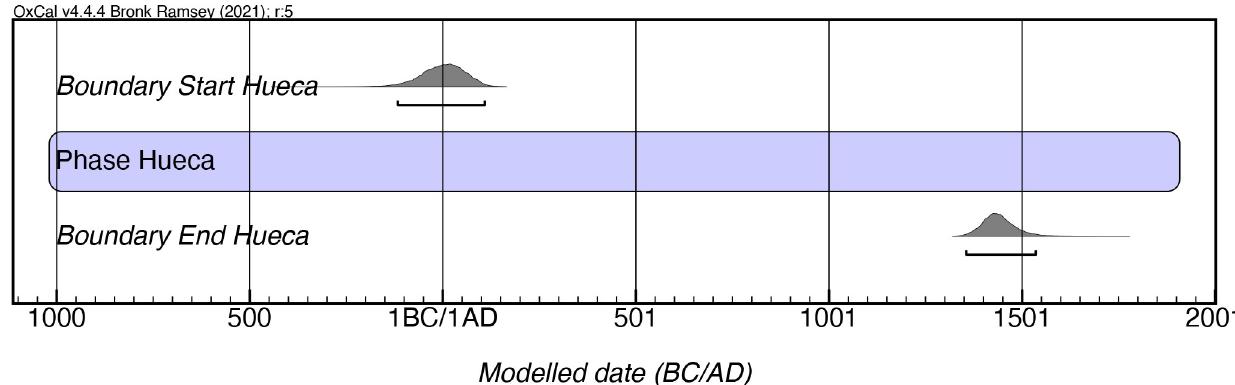
Fig 7. Modeled date ranges for the La Hueca style in Puerto Rico. Probability distributions indicate modeled 2 σ (95.4%) confidence intervals for beginning and end of phase.